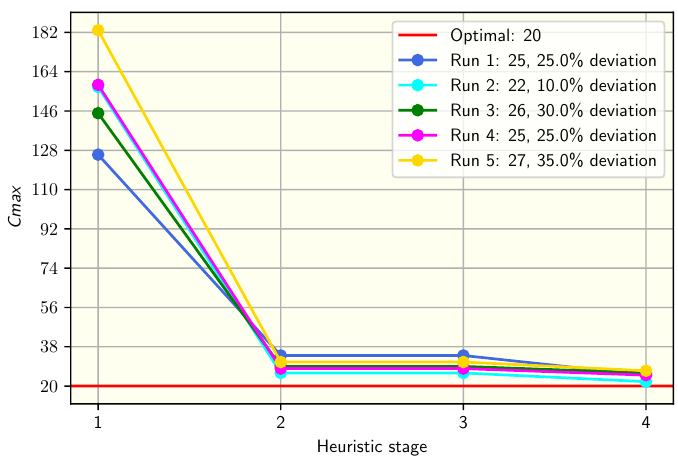
Figure 4. Five runs and its results for a large instance in alternative